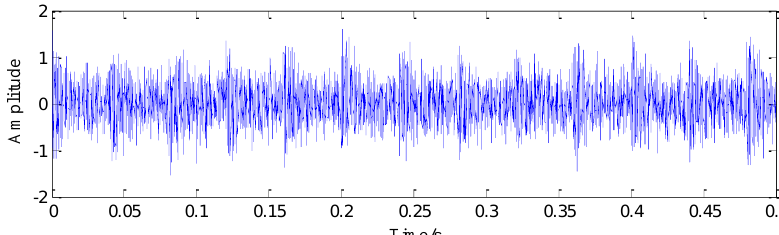
Figure 7. Waveform of the noisy simulated signal.